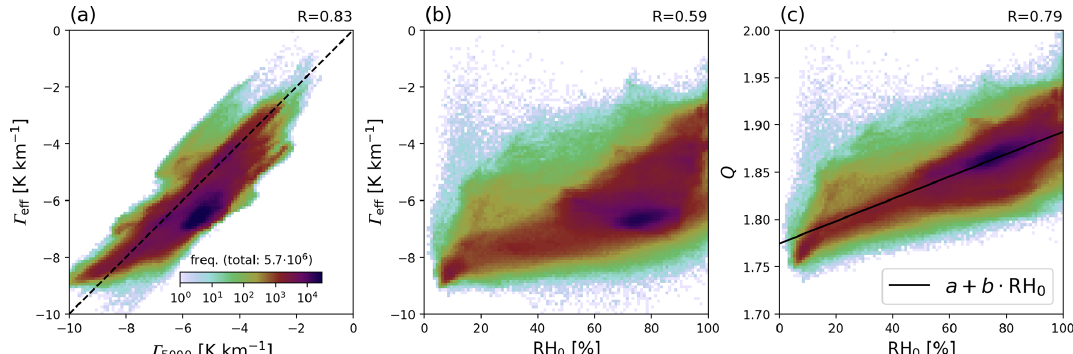
Figure 5. Relations between lapse rate, RH 0 , and ratio Q for ERA5 data on 18 June 2018. (a) Relation between the actual lapse rate (calculated from the temperature difference between ground and 5 km altitude) and the effective lapse rate. (b) Relation between RH 0 and effective lapse rate. (c) Relation between RH 0 and the ratio Q as defined in Eq. (18), where the black line shows the linear fit a + b · RH 0 .